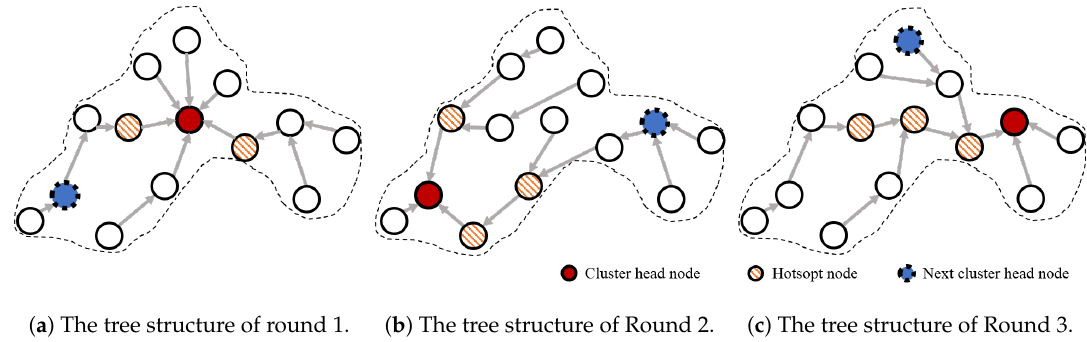
( b ) The tree structure of Round 2. ( c ) The tree structure of Round 3. Figure 3. Changes in the tree structure within a